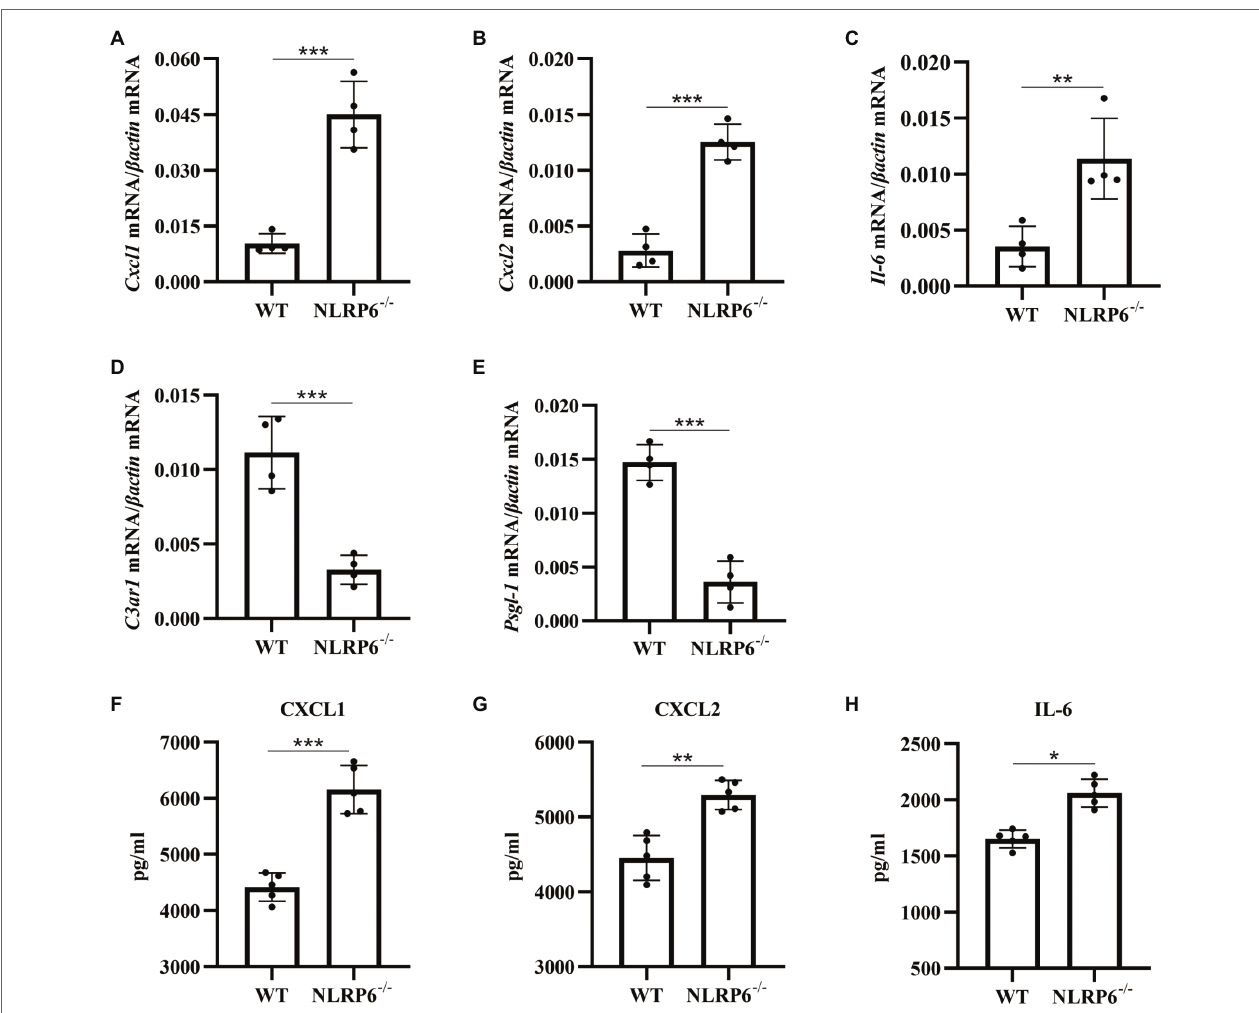
FIGURE 4 | NLRP6 deficiency promotes the recruitment of neutrophils and macrophages by regulating chemokine expression. WT and NLRP6 − / − mice were intranasally infected with S. pneumoniae (5 × 10 7 CFU) for 24 h and then lung tissues were collected. Transcript levels of Cxcl1 (A) , Cxcl2 (B) , Il-6 (C) , C3ar1 (D) , Psgl-1 (E) normalized with β -actin were quantified ( n = 4/group). The levels of CXCL1 (F) , CXCL2 (G) , and IL-6 (H) were measured by ELISA ( n = 5/group). Statistical significance was shown as * p < 0.05, ** p < 0.01, and *** p <